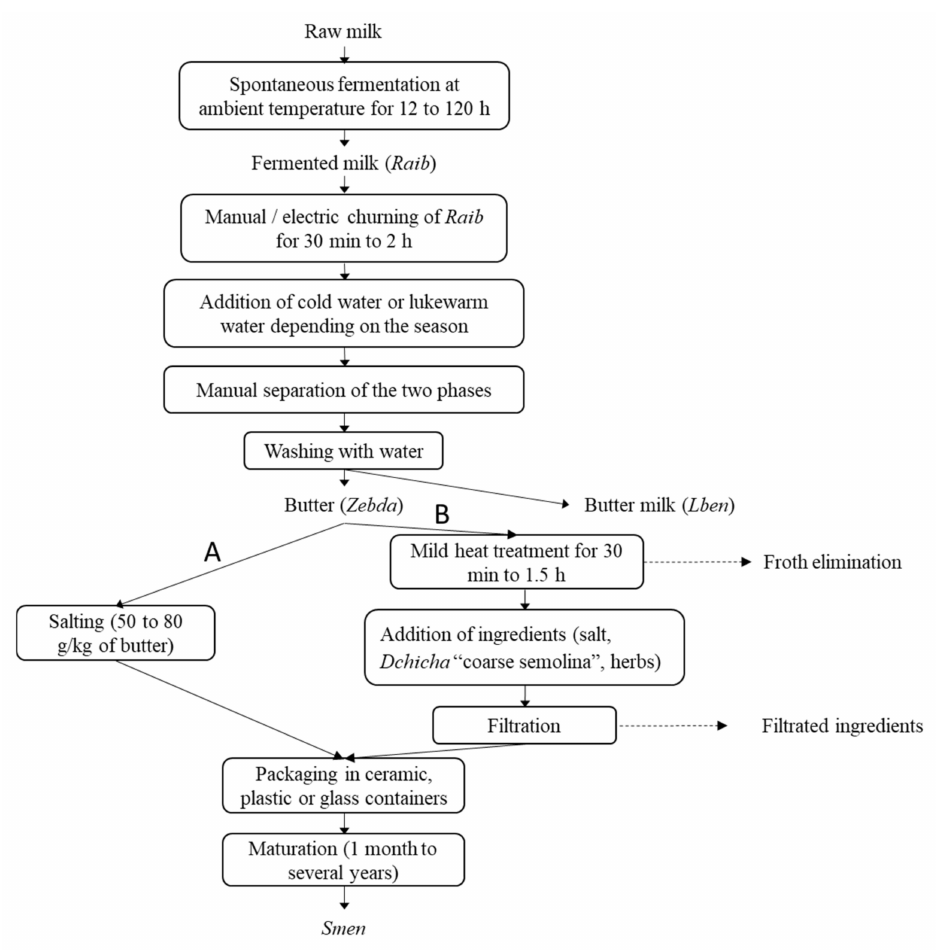
Figure 1. Flow diagram showing the traditional Smen production process according to the salting ( A ) and heat-treatment ( B )